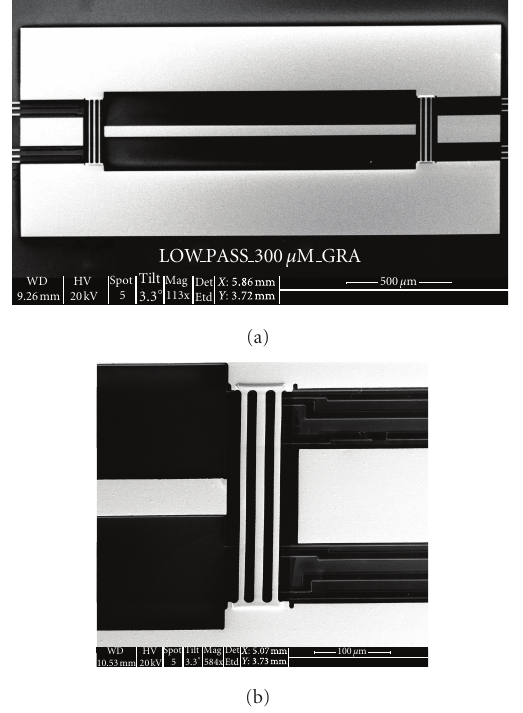
Figure 4: (a) A SEM image of the fabricated low-pass filter (top view). Three narrow bridges at both sides represent the tunable capacitance. Chip size (2.3mm × 1mm) and (b) an enlarged image of the low-pass filter at the capacitance area.